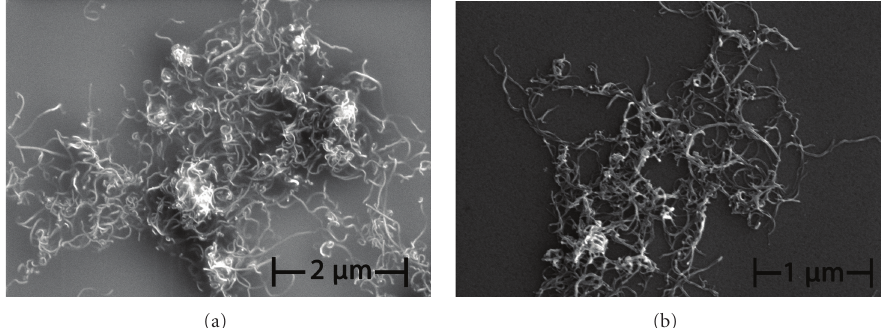
Figure 11: Scanning electron micrographs of the MWCNTs after TGA sample preparation. MWCNTs dispersed 10min in a bath sonicator (a) and at 70% for 72 min